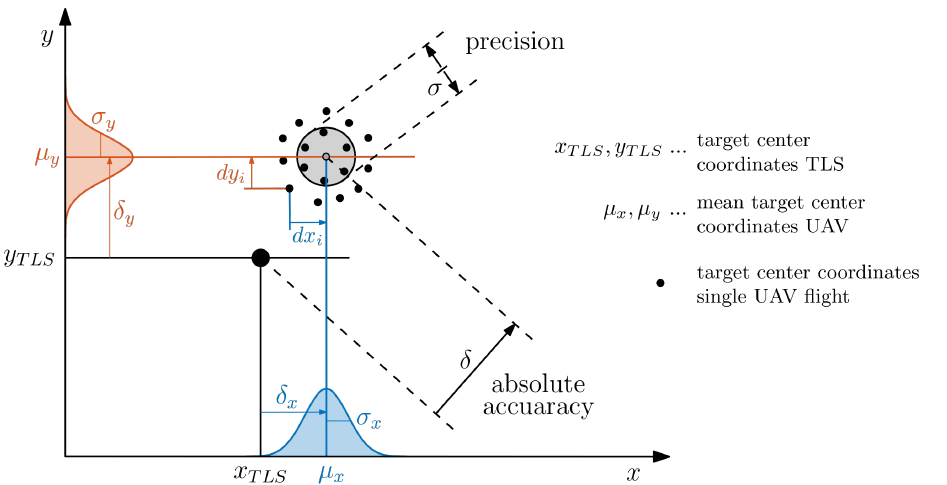
Figure 7. Relation of target center coordinates from TLS to multiple estimates of the same target from UAV data sets. Included quality parameters are the absolute accuracy and precision.